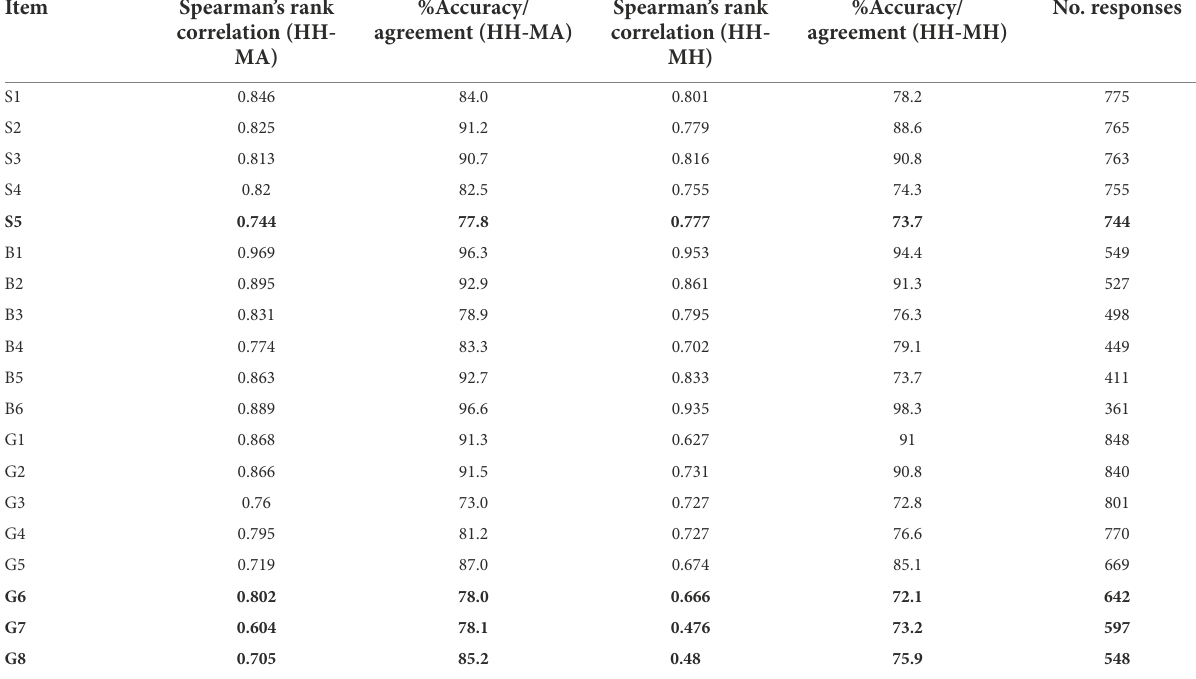
TABLE 4 Correlation and agreement